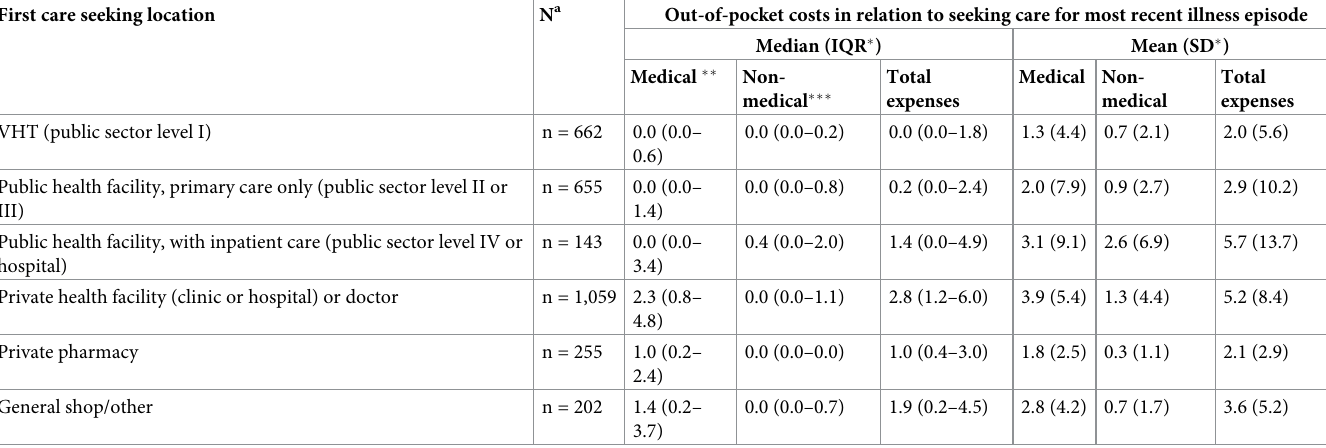
Table 9. Medical, non-medical and total out-of-pocket costs of seeking care for children with an episode of MDP, USD 2011 stratified by the first location